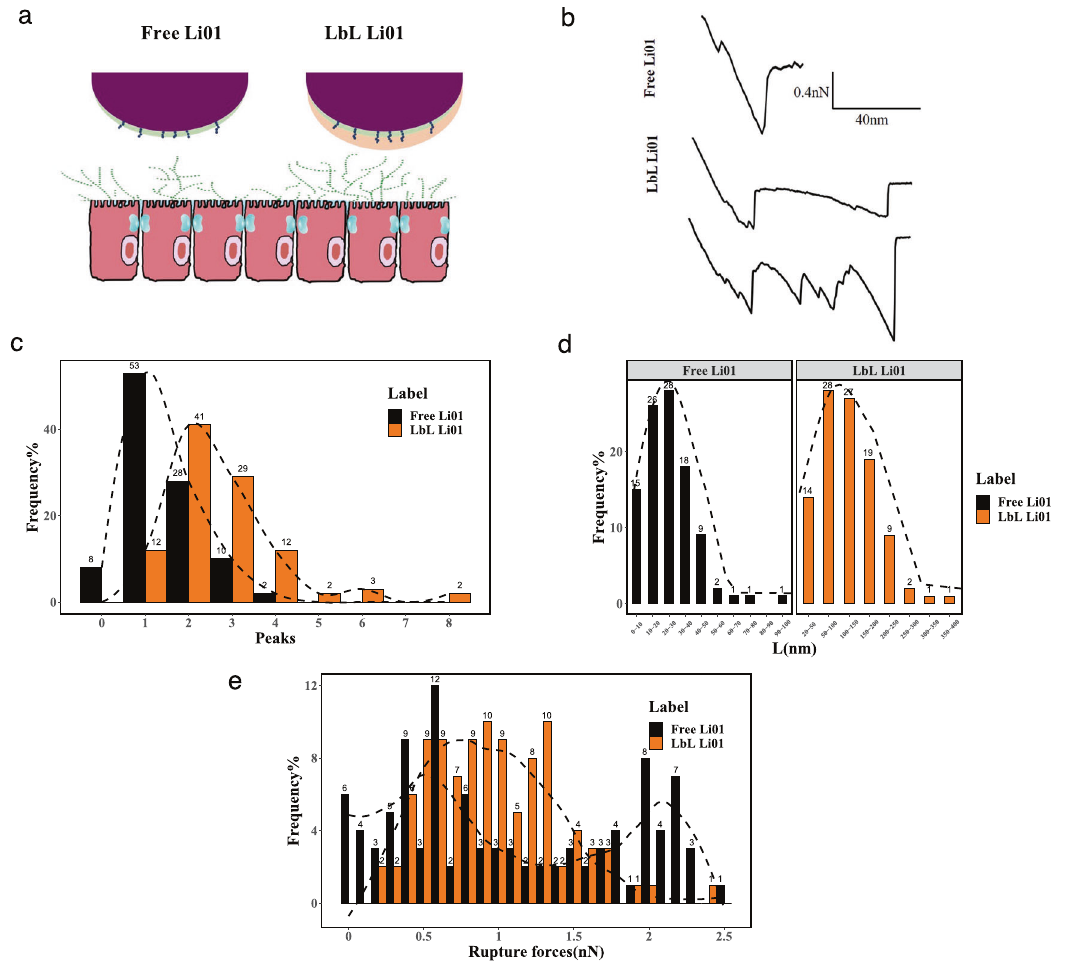
Fig. 4 Strength and dynamics of the interactions between mucin and free Li01 and LbL Li01. a Li01-mucin and LbL Li01-mucin interactions were determined by measuring the binding forces between a mucin tip and Li01/LbL Li01 by using AFM. b Representative force curves of Li01-mucin and LbL Li01-mucin. Number of ruptures histogram ( c ), rupture length histogram ( d ) and adhesion force histogram ( e ) were obtained by recording force curves in a buffer between a mucin tip and Li01. The black line is a Gaussian fi t to the data. Each data point in this plot represents the mean ± SEM ( n = 100 force